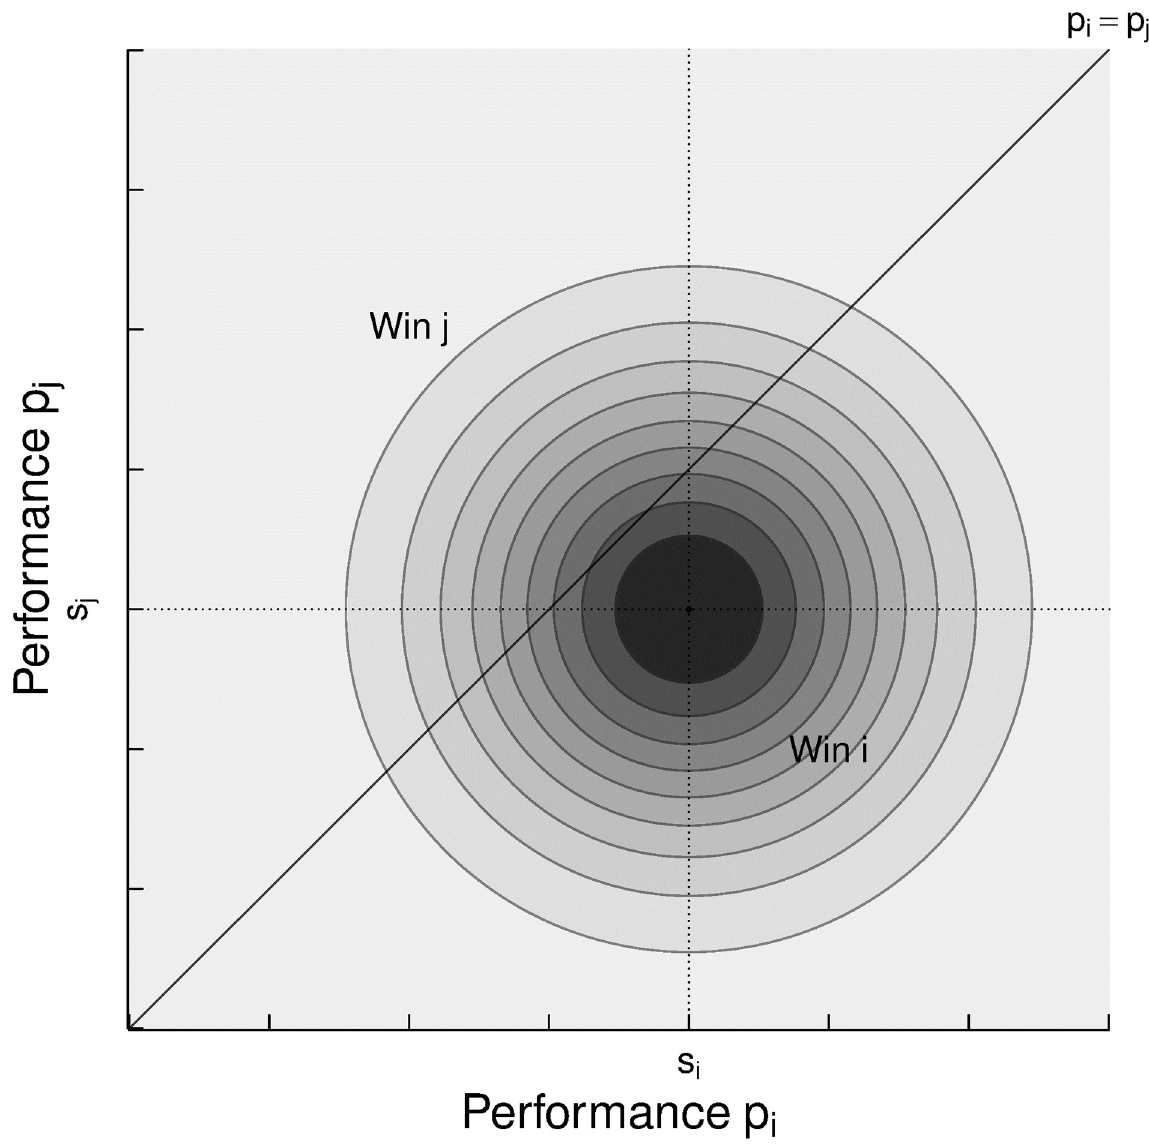
Fig 6. Joint probability of the performance of two players i , j under the assumption of s diagonal p i = p j represent “difference of performances” isobars d ij = p i − p j